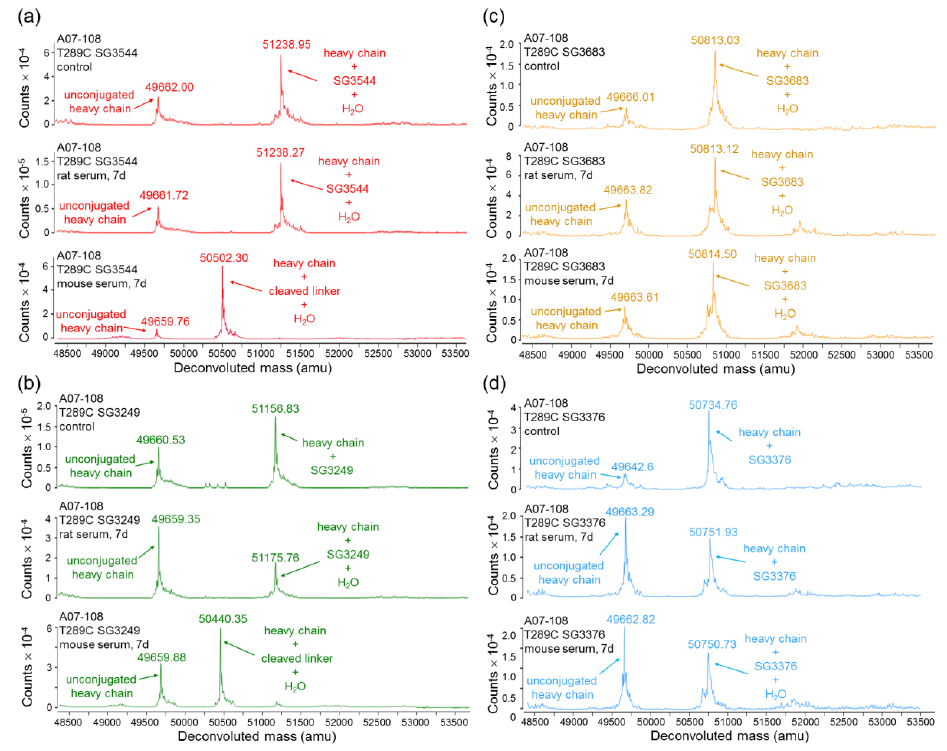
Figure 4. Mass spectrometry analysis of serum-incubated ADCs. ( a ) A07-108-T289C SG3544; ( b ) A07-108 T289C SG3249; ( c ) A07-108-T289C SG3683; and, ( d ) A07-108-T289C SG3376. All of the samples were analyzed immediately after addition to serum (control), after incubation in rat serum for seven days at 37 ◦ C, and after incubation in mouse serum for seven days at 37 ◦ C. All of the spectra are zoomed in to show the heavy-chain